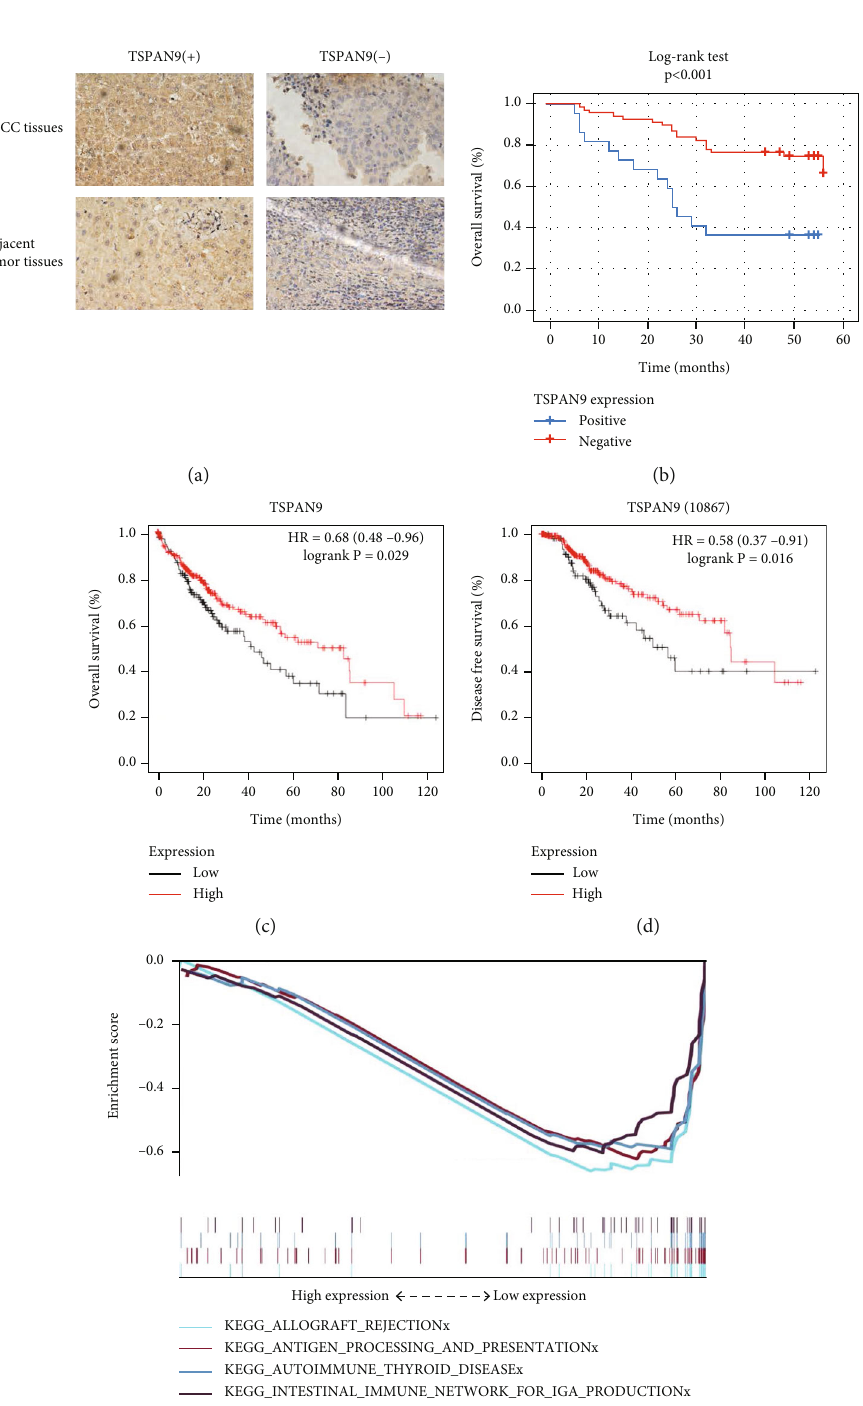
Figure 1: The correlation between the expression of TSPAN9 and HCC prognosis. (a) Representative results of immunohistochemical staining. (b) Log-rank test of survival time in patients with HCC. (c and d) The Kaplan-Meier plotter on the analysis to OS (c) and DFS (d) of TSPAN9 in HCC patients. (e) In HCC, the enrichment of pathways negatively correlated with the expression level of